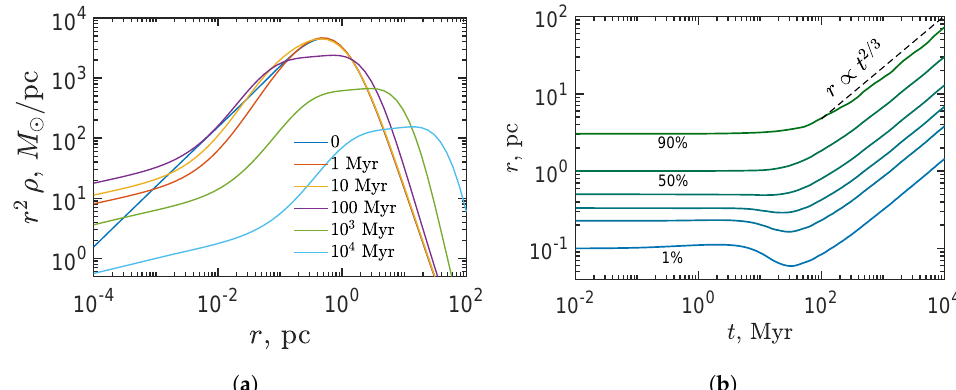
Figure 4. The evolution of the mass distribution is shown. ( a ) The density profile at different times. ( b ) The evolution of the mass shells containing 1, 5, 10, 20, 50, and 90 percent of the cluster mass, respectively.